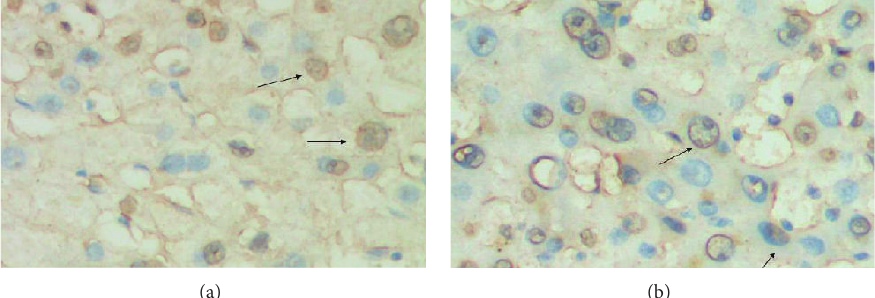
Figure 4: TUNEL detected apoptosis in HCC tissues. Apoptotic nuclei were stained in brownish yellow (indicated by arrow), while normal nuclei were stained in blue (magnification × 400).